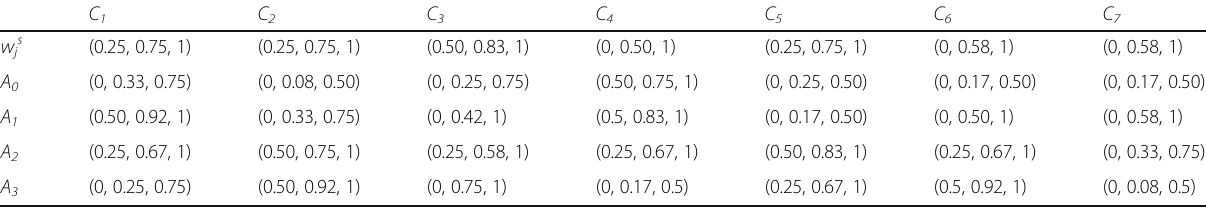
Table 3 Aggregated fuzzy ratings of route alternatives and subjective fuzzy weights of criteria